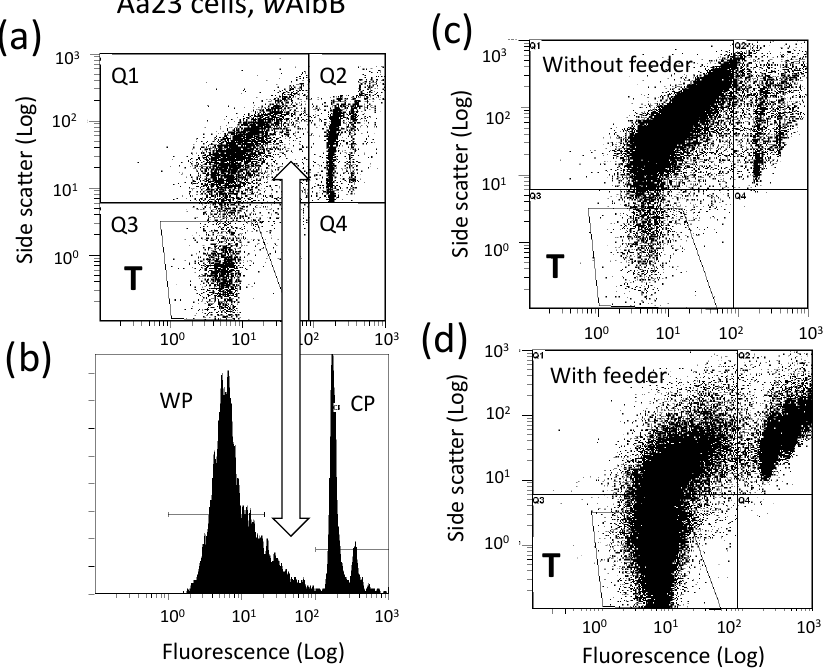
Figure 3. Cytometric analysis of crude Wolbachia preparations from Aa23 cells directly resuspended in culture medium. Panel ( a ), scatter plot showing events in Q1 that interfere with quantitation of the WP in the corresponding histogram shown in Panel ( b ). The vertical white open arrow indicates corresponding positions in the two panels. WP, Wolbachia peak; CP, cell peak. Panel ( c ), an independent preparation of Aa23 cells assayed after two weeks in the absence of a C7-10 feeder layer; Panel ( d ), a replicate Aa23 inoculum added to a confluent monolayer of mitomycin C-treated C7-10 cells. Events in polygon T, which excludes Q1 events (shown in ( a , c , d )) were used to estimate relative Wolbachia